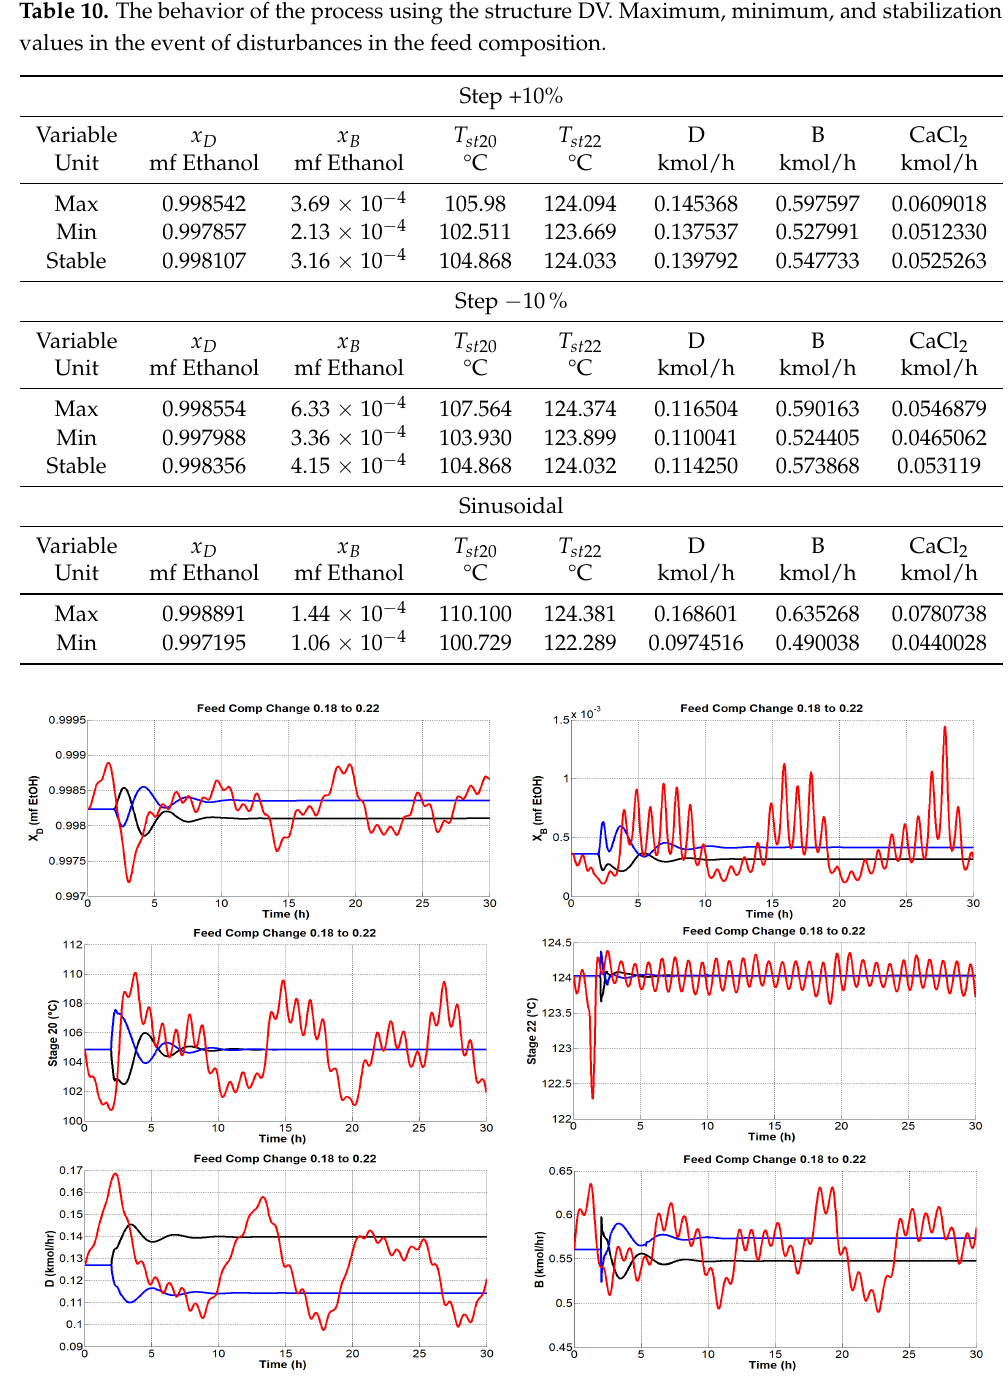
Figure 16. The behavior of structure DV for the dual temperature control with changes in the main feed in a stepwise form of 10% mf ( black ) and − 10% mf ( blue ), also sinusoidal changes in the mole fraction ( red